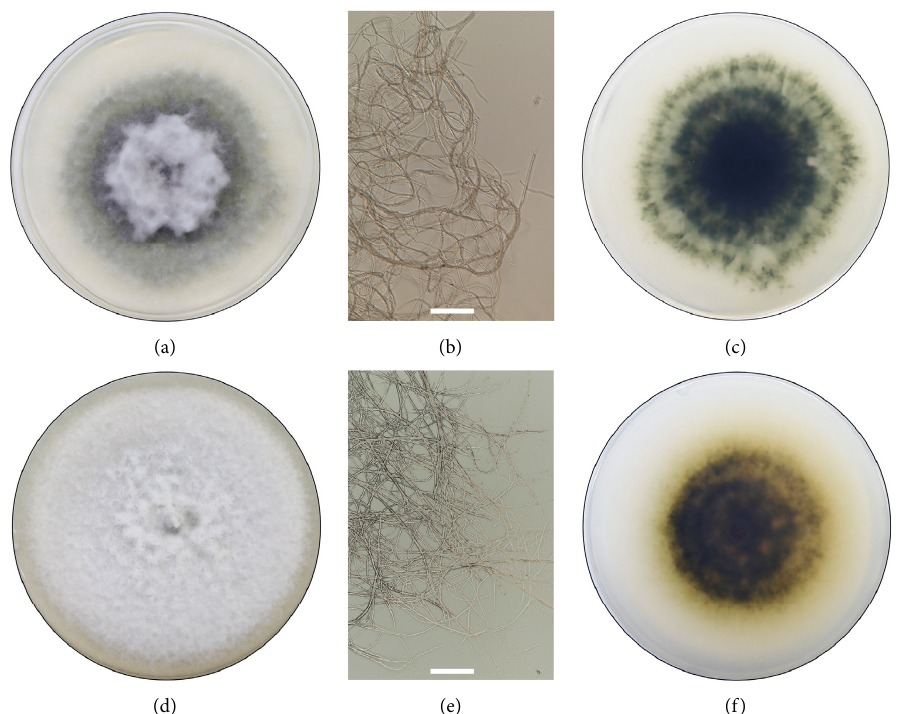
Figure 3: Morphological characteristics of pathogenic fungus of kiwifruit fruit rot disease. (a) and (d) observe surface of colony (front), (c) and (f) observe surface of colony (back), (b) and (e) mycelial morphology. (a)–(c) F1 strain. (d)–(f) F4 strain. Scale bar: